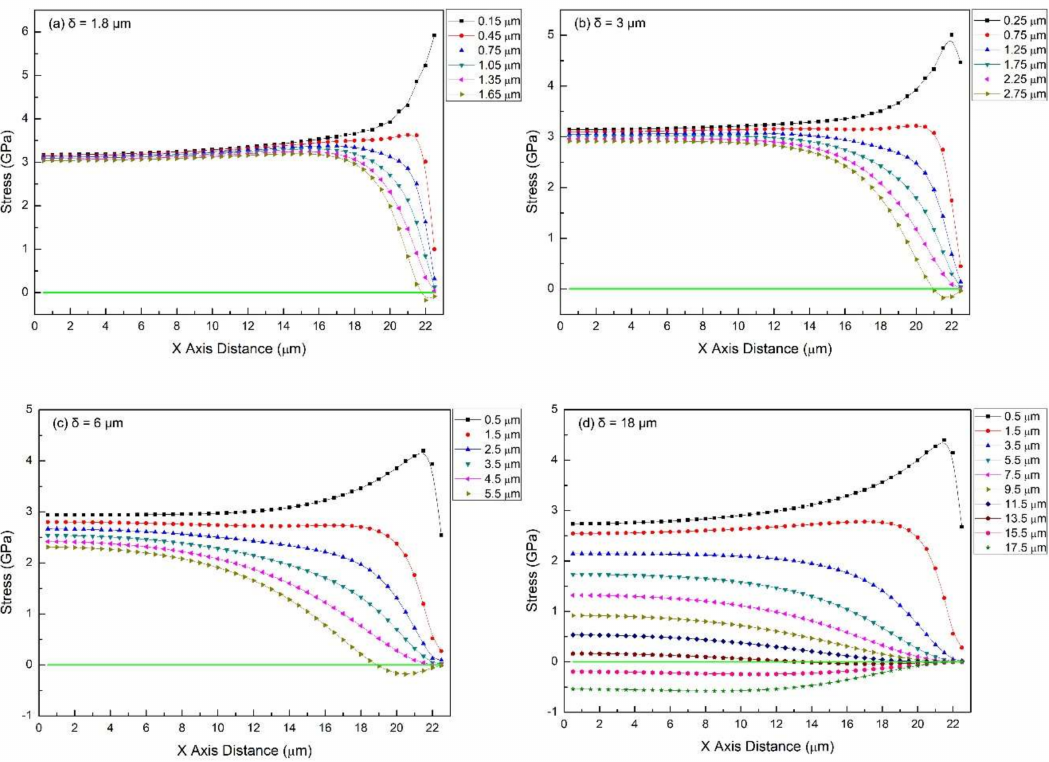
Figure 2. The in-plane stress distribution (dot-line plot) in films of different thicknesses for the case of the film/substrate system being tested in tension: ( a ) δ = 1.8 µ m, ( b ) δ = 3 µ m, ( c ) δ = 6 µ m, ( d ) δ = 18 µ